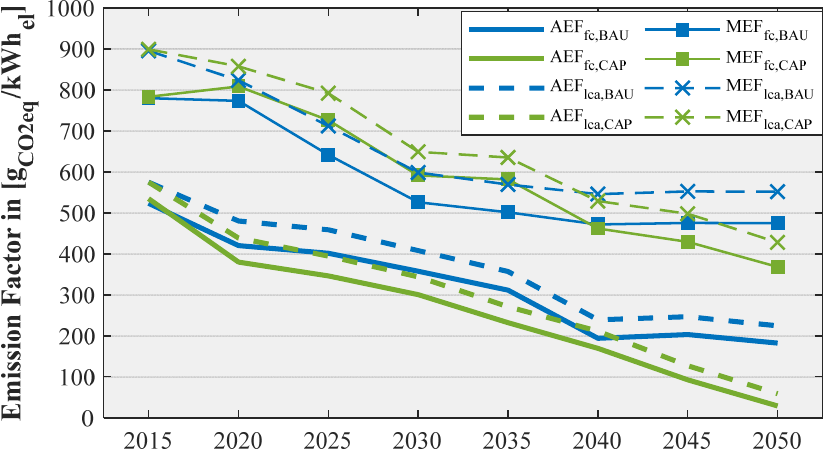
Figure 9. Comparison of the annual averaged emission factors. The scenarios are highlighted in color, the use of specific emission factors is differentiated by line type, and the MEF is highlighted with markers. Model results. Table 2. Annual average emission factors by characteristic, scenario, fuel-specific factors, and the associated standard deviation of the hourly values. Model results.